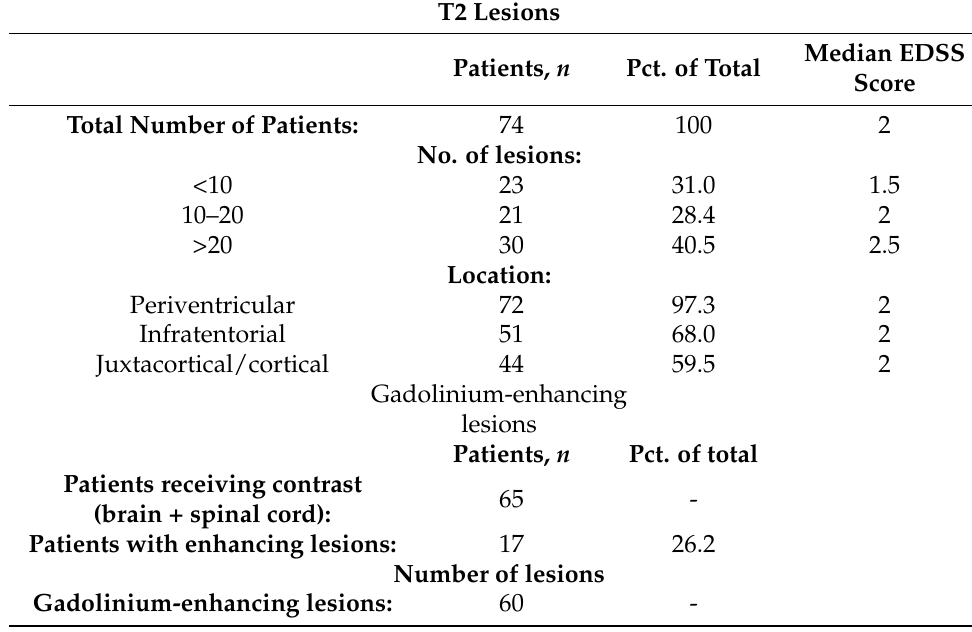
Table 1. Results from brain MRI and corresponding EDSS